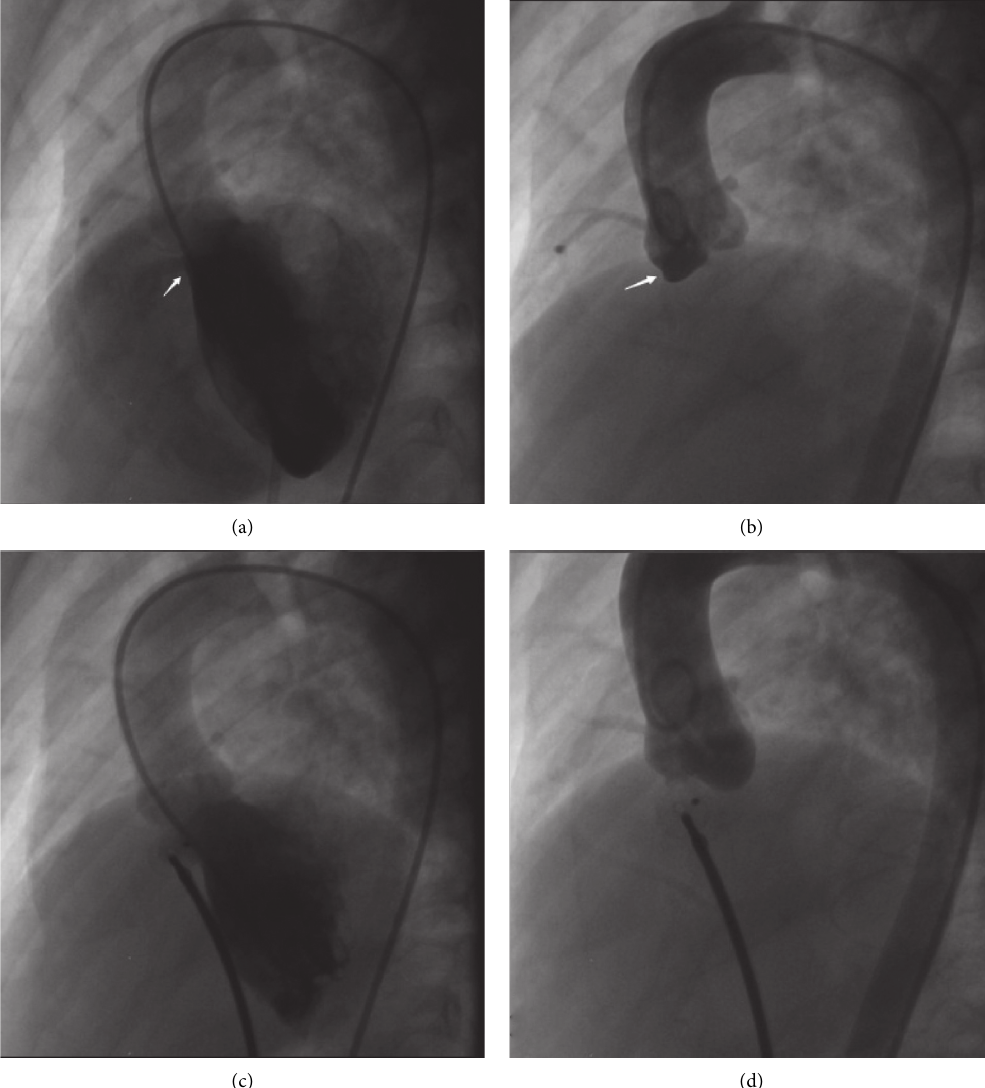
Figure 1: (a) LV angiography (60 left anterior oblique and 20 cranial) using a pigtail catheter to determine the location, shape, and size of VSD (white arrows). (b) Aortic root angiography (60 left anterior oblique and 20 cranial) demonstrating moderate AVP (white arrows). (c) Before the occluder released, LV angiography showed no residual shunt and satisfying position and shape of the occluder. (d) Aortic root angiography confirming the absence of AR prior to release of the occluder (LV � left ventricle; VSD � ventricular septal defect; AVP � aortic valve prolapse; AR � aortic